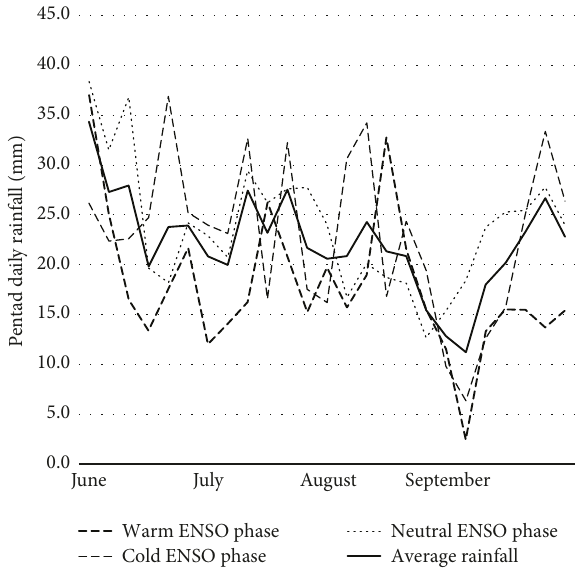
Figure 9: Pentad (from daily data) rainfall changes in Watawala station for JJAS